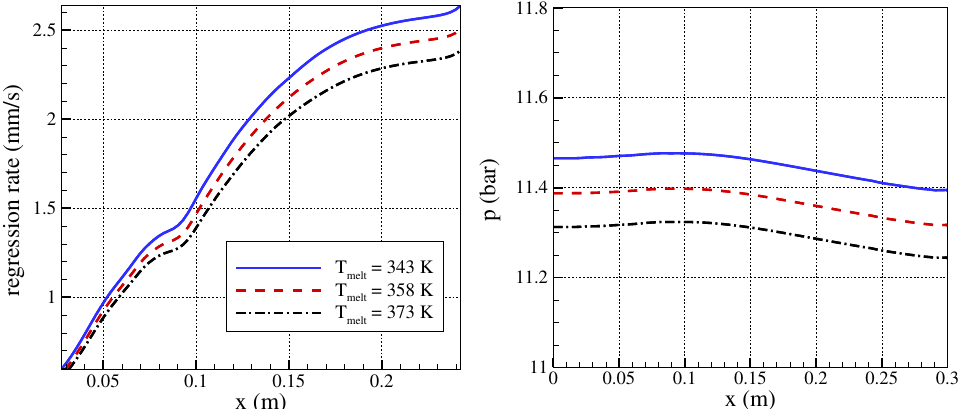
Figure 7. Effect of paraffin’s melting temperature on regression rate and